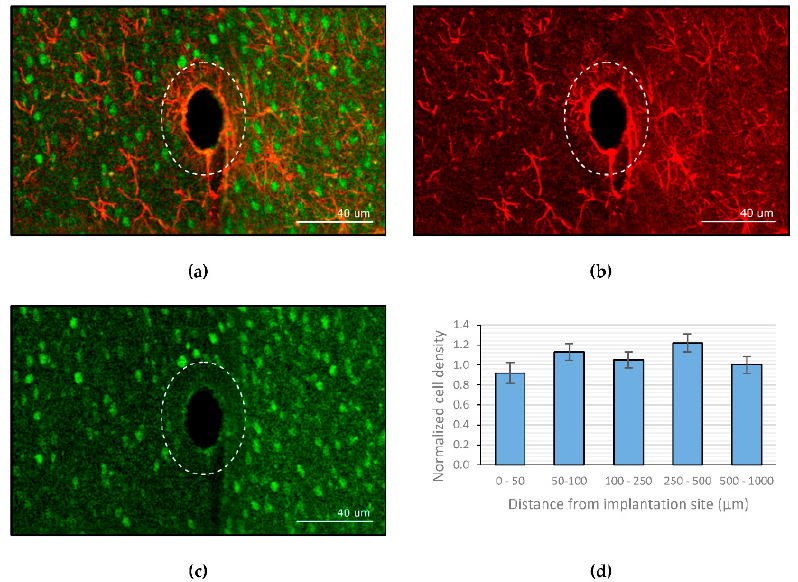
Figure 7. Confocal imaging of brain slices: ( a ) overlay of both the glial fibrillary acidic protein (GFAP) and neuronal nuclei (NeuN) stained channels. ( b ) GFAP channel. ( c ) NeuN channel. ( d ) Normalized neuronal density relative to the site of implantation (the error bars represent the standard deviation, n = 6). Figure and caption reused from Kil et al. [188]. Used under the Creative Commons License (http://creativecommons.org/licenses/by/4.0/ (accessed on 28 January 2021)).